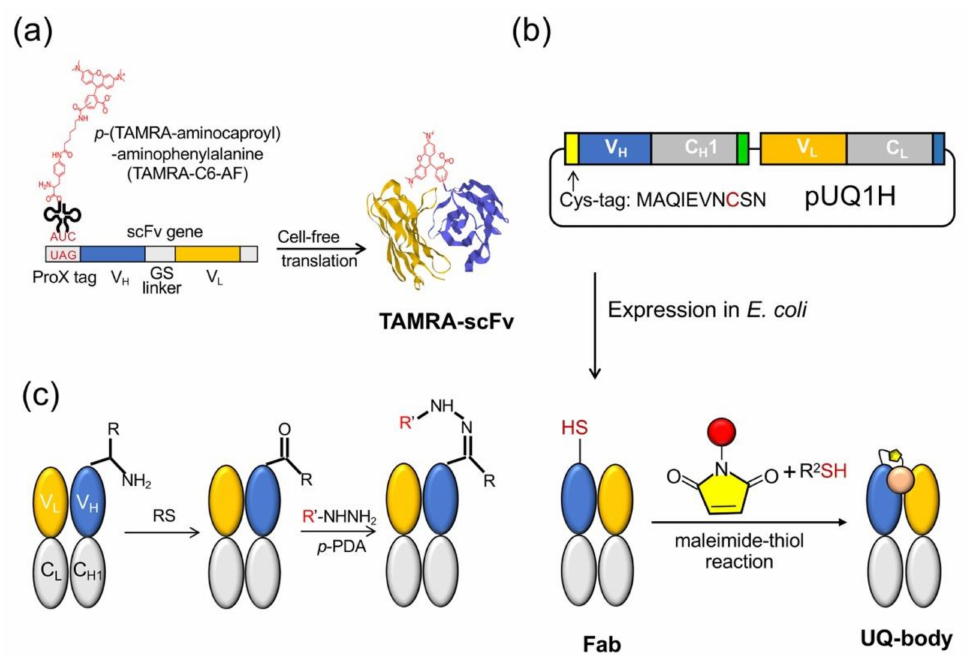
Figure 2. Quenchbody preparation. ( a ) Cell-free system for the scFv type. ( b ) Post labeling method to prepare an ultra-Q-body (UQ-body) with antigen-binding fragment (Fab) produced in E. coli . ( c ) Method based on transamination at the N -terminus. RS: Rapoport’s salt; p -PDA: p